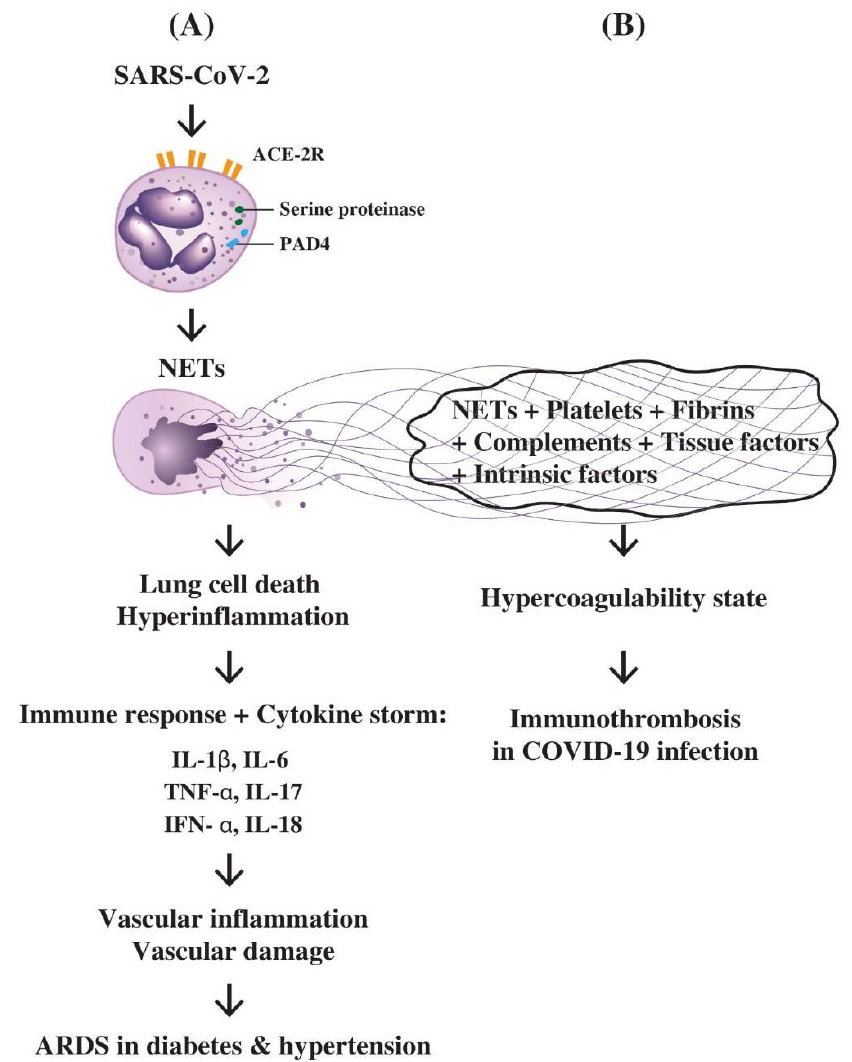
Figure 5. The molecular basis of PMNs in inducing hyperinflammation of lung, cytokine storm and immunothrombosis during SARS-CoV-2 infection in patients with diabetes or hypertension. ( A ) Attachment of SARS-CoV-2 virus to ACE2 receptors on PMN results in the enzymatic activation of serine proteinase and PAD4 to induce NETs formation. The NETs can cause pulmonary epithelial cell death and hyperinflammation in the lung. The overwhelming immune responses with profound proinflammatory cytokine production including IL-1β, IL-6, IL-8, IL-17, IFN-α, and TNF-α elicit cytokine storm, extensive vascular inflammation and damage leading to acute respiratory distress syndrome (ARDS); ( B ) The trapping of platelets, fibrins, complements, tissue factors, intrinsic coagulation factors, and tissue debris by NETs released from PMNs lead to a hypercoagulability state of the body. Finally, immunothrombosis in the lung, heart, brain, kidney or gastrointestinal tract occurs in COVID-19 disease.